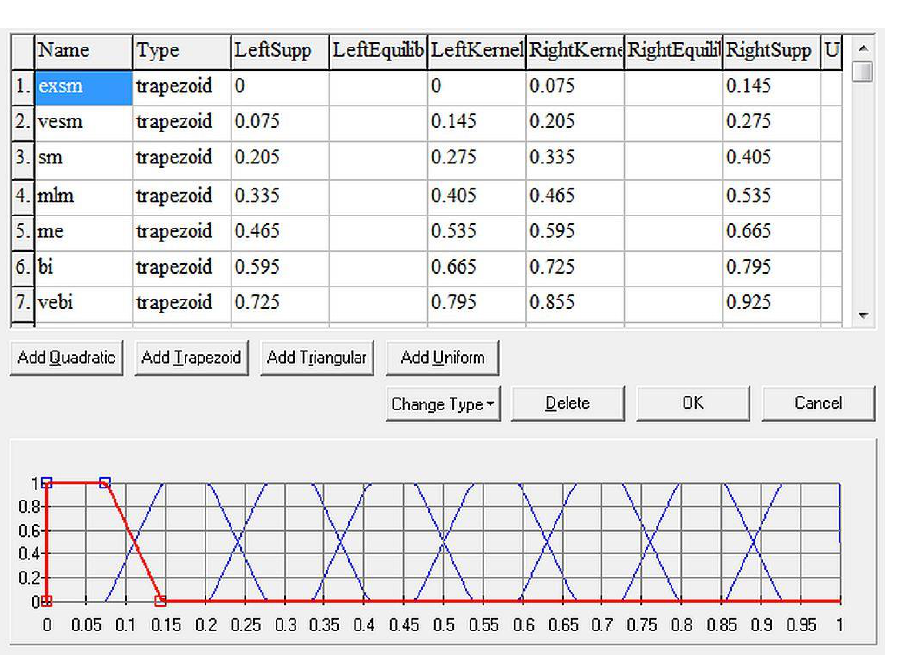
Figure 6. Graphic representation of the output value set V5.